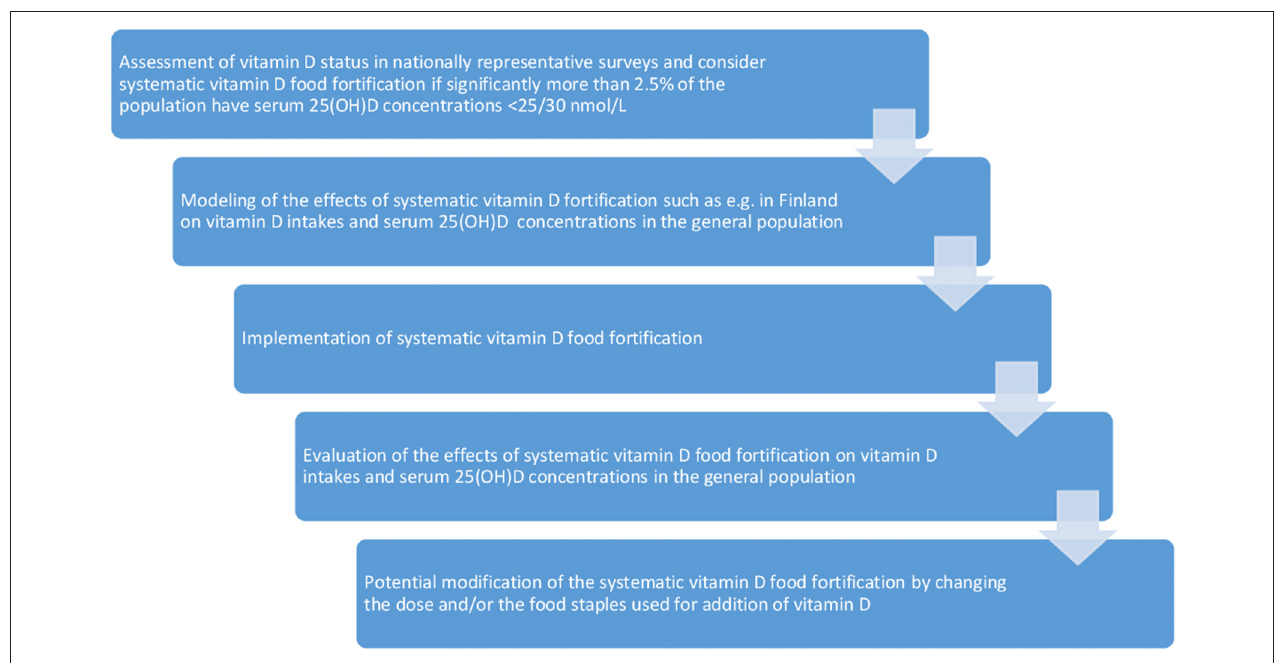
FIGURE 2 | Guidance for vitamin D food